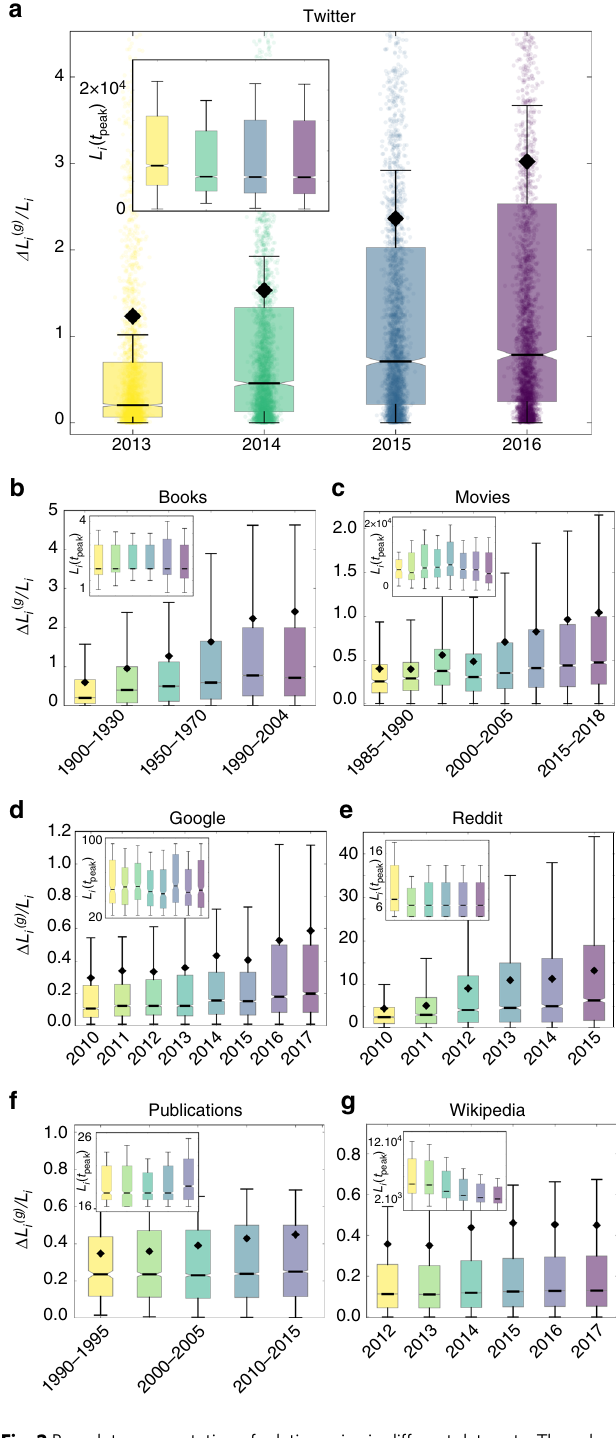
Fig. 2 Box-plot representation of relative gains in different data sets: The values of the relative gains Δ L ð g Þ i = L i , shown in a box-and-whisker representation for a Twitter, b Books, c Movies, d Google, e Reddit, f Publications, and g Wikipedia. The median is shown as a black bar and the mean as a black diamond. Whiskers are chosen to show the 1.5 of the interquartile range. In a the data points are included for illustration, in the other plots they are not shown. The insets show the same representation of the peak values L i ( t peak ) over the same time intervals (without mean value). Source data are provided as a Source Data fi